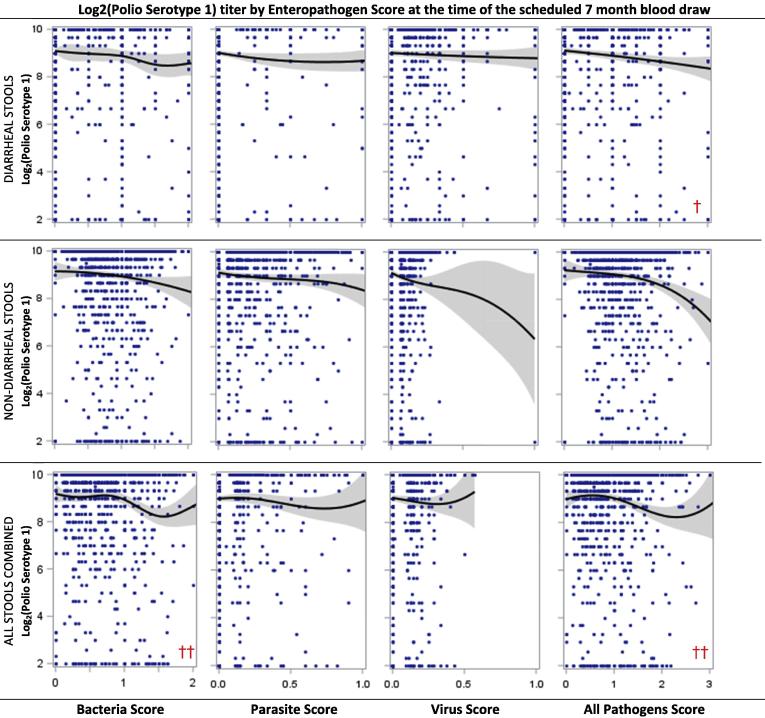
Polio serotype 1 titers by enteropathogen detection scores (bacteria, parasites, viruses, all combined) computed for diarrheal, non-diarrheal and all stools combined among children receiving at least 3 OPV doses at the scheduled 7 month blood draw. Scatter plots include penalized B-splines (10 knots) and 95% confidence intervals. A chi-square test was evaluated for each scatter plot comparing the percent of children who failed to seroconvert in a high vs. low enteropathogen score group where high was defined as the approximate 75th percentile of the enteropathogen score (i.e., 1.0, 0.33, 0.15, and 1.25 for Bacteria, Parasite, Virus and All Pathogens Scores, respectively); † indicates p<0.05; †† indicates p<0.01.